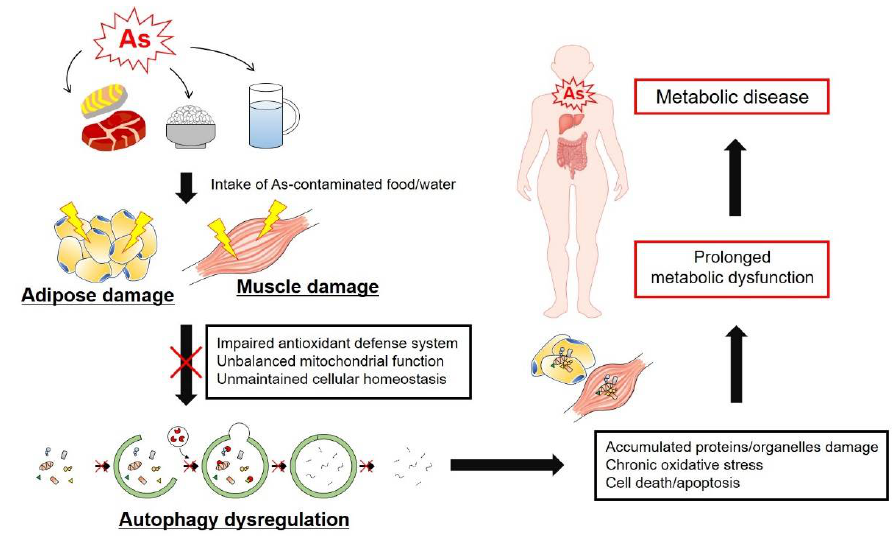
Figure 4. Autophagy dysregulation caused by chronic As exposure in adipose and muscle